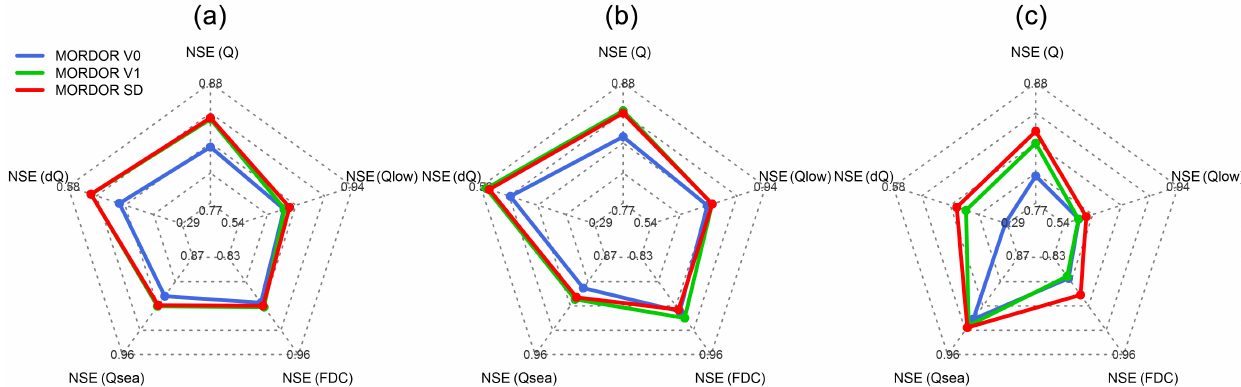
Figure 4. Mean NSE for each hydrological signature and for the three model versions: (a) for the entire catchment sample (50 catchments), (b) for the pluvial sample (35 catchments) and (c) for the nival sample (15 catchments).